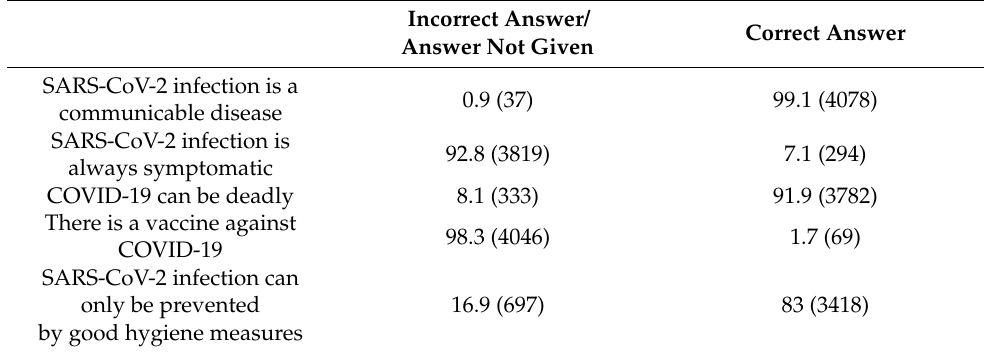
Table 3. Knowledge of the study sample regarding SARS-CoV-2 infection-COVID-19 disease.